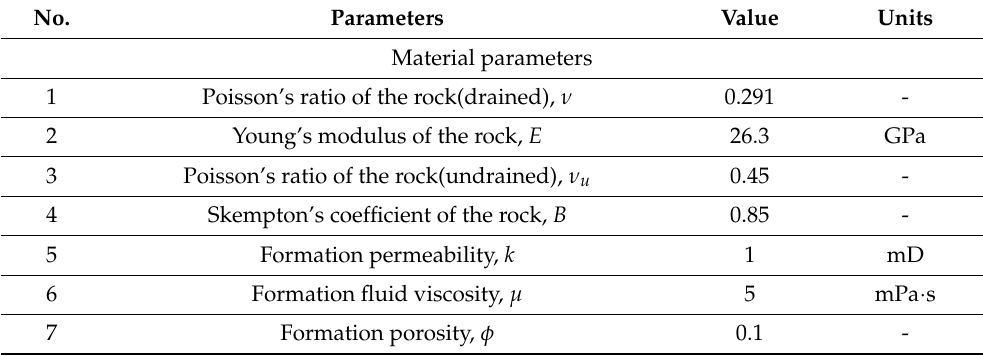
Figure 2. Average effective stress of the bottomhole rock after the formation was drilled. ( a ) Warren et al.’s result; ( b ) Hu et al.’s result; ( c ) Our result. Table 2. Basic parameters of the thermal-fluid-solid coupling